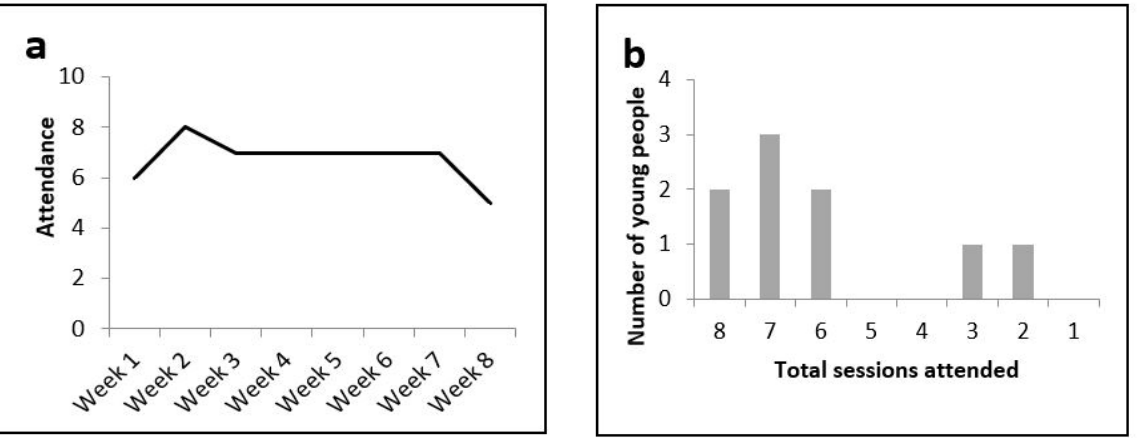
Figure 2. ( a ) Attendance record during Phase 1 of MST4Life; ( b ) the total number of sessions attended by each young person. by each young